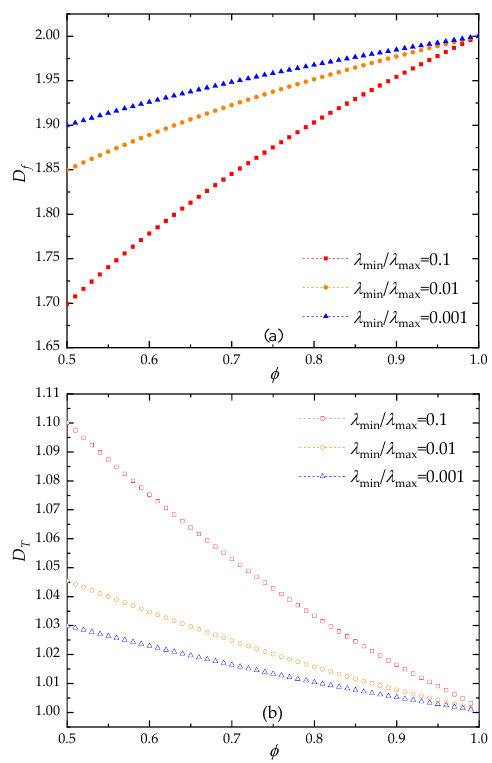
Figure 7. The relationship between fractal dimension and porosity: ( a ) pore fractal dimension; ( b ) tortuosity fractal dimension.